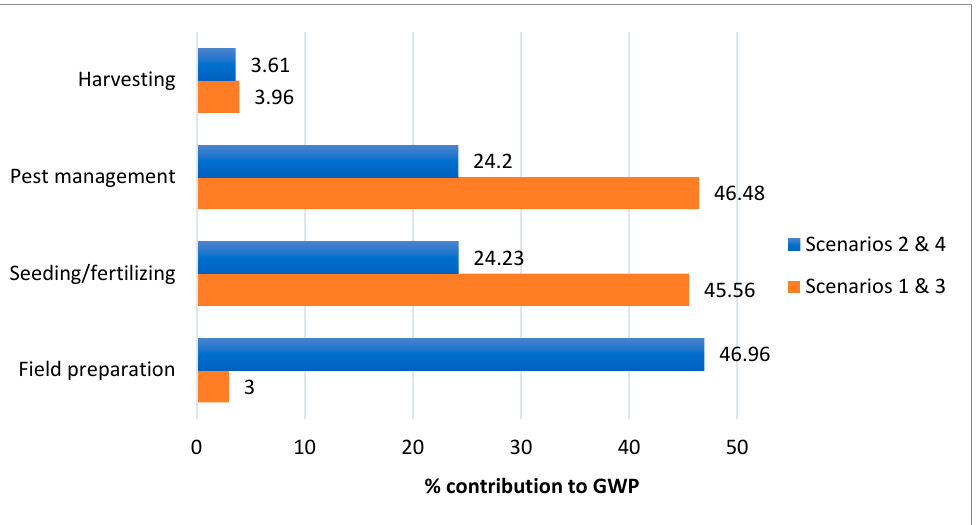
Figure 6. Percentage contribution of scenarios 1 and 3, and 2 and 4 to GWP values per process according to the results of the OpenLCA.